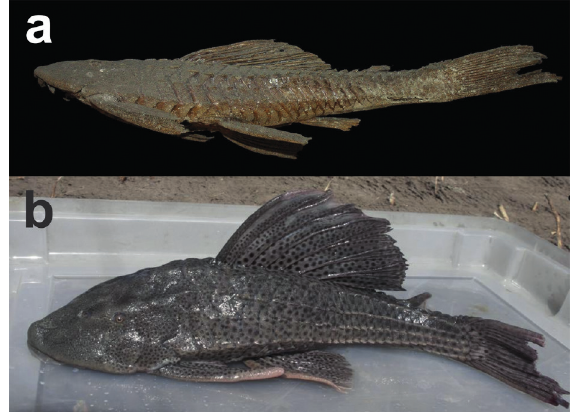
Figure 7 - Hypostomus spiniger : ( a ) holotype, ZMB 7444 (Photographs: Allen, Mark); ( b ) live specimen from Uruguay River Chajarí, entre